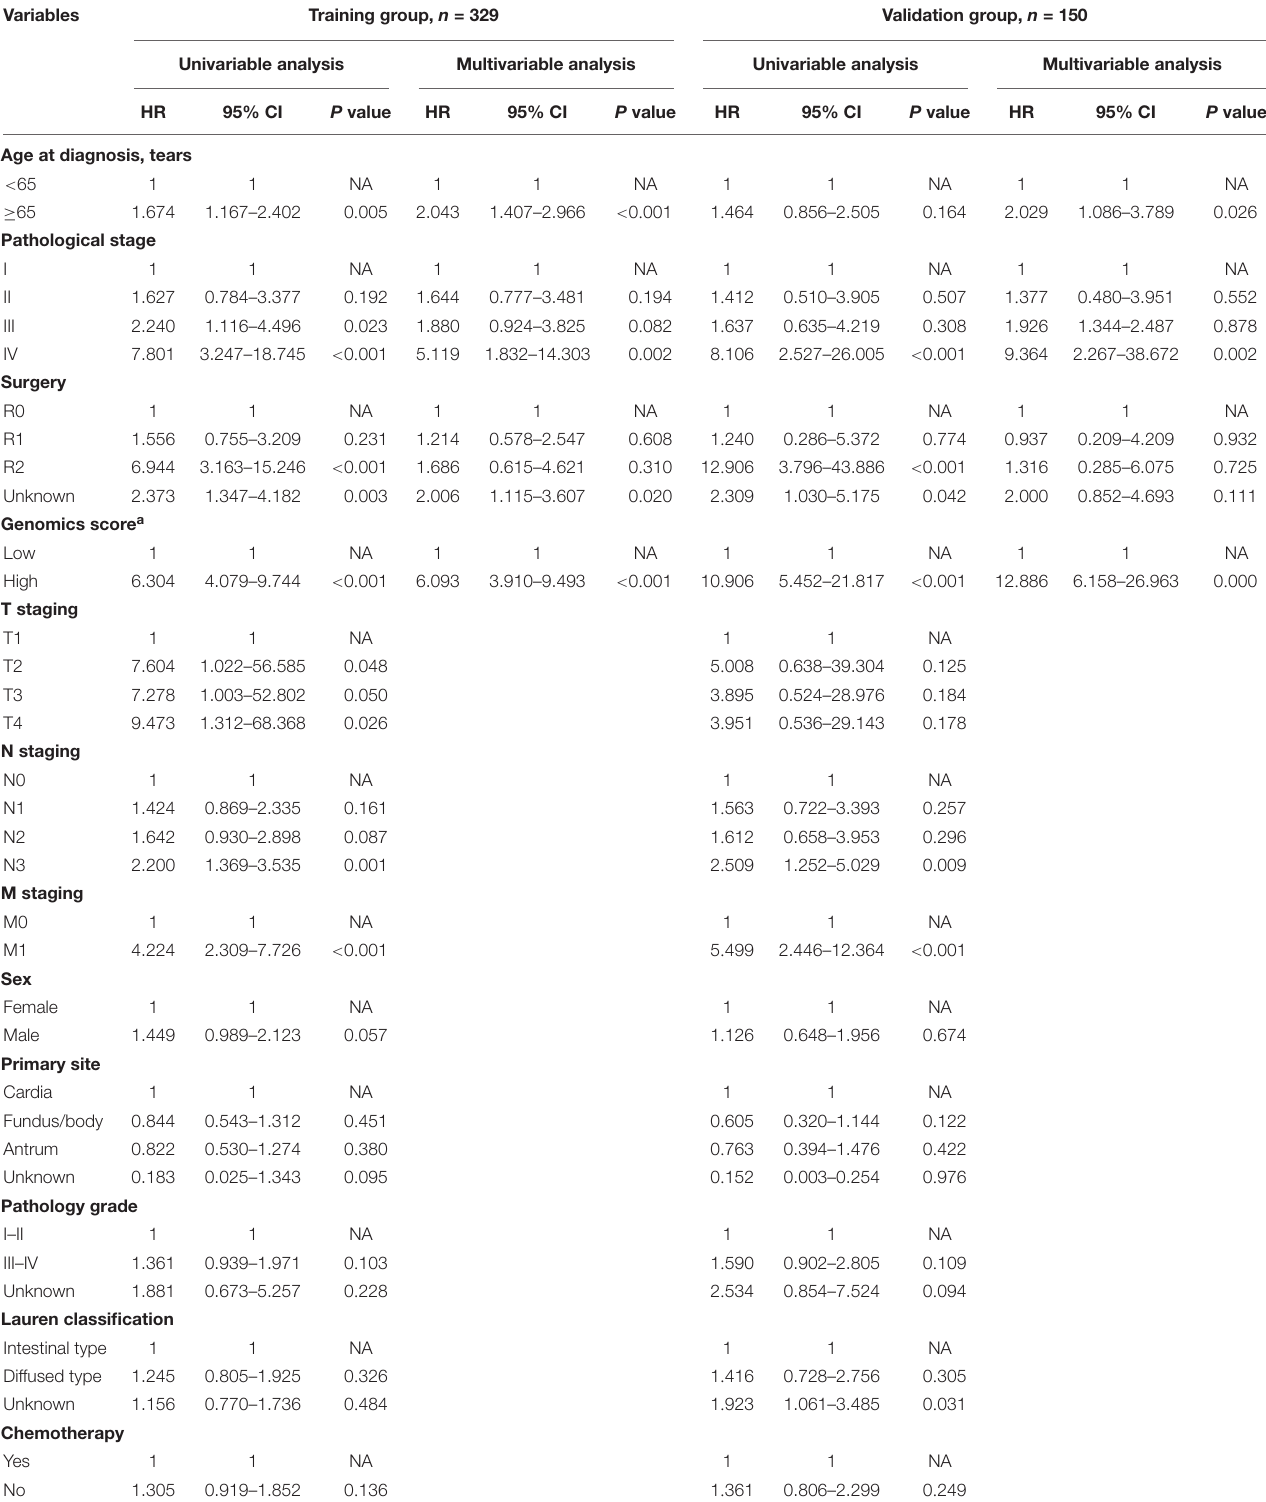
TABLE 1 | Univariable and multivariable analyses of the genomics score and the clinicopathological characteristics for overall survival in the training group and the validation